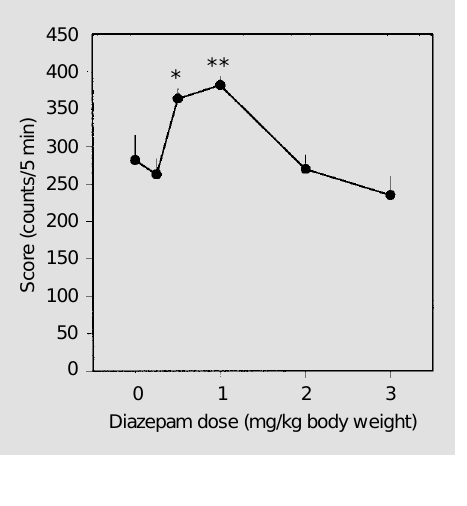
Figure 2 - Locomotor activity es- timated by the median total ex- ploration activity of intact rats treated with different diazepam doses. *P<0.05 vs dose “0” and **P<0.01 vs dose “0” (nonpara- metric Dunn test). Other statisti- cal comparisons: P<0.05 for the 2 mg/kg dose compared to the 1 mg/kg dose, and P<<0.05 for the 3 mg/kg dose compared to the 1 mg/kg dose (nonparamet- ric Dunn